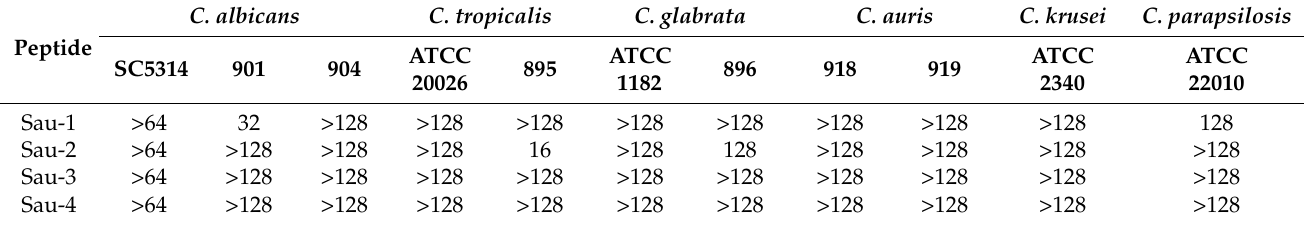
Table 1. Minimum inhibitory concentration (MIC, μ g/mL) of the target peptides against Candida isolates. C. Peptide